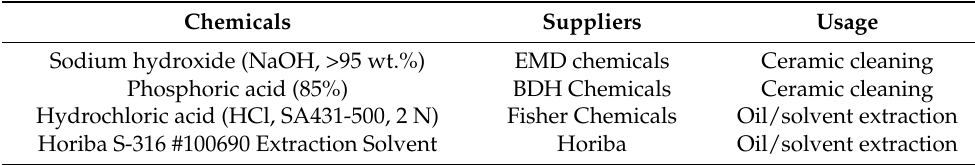
Table 1. Chemicals and salts used for ceramic cleaning and oil/solvent extraction.